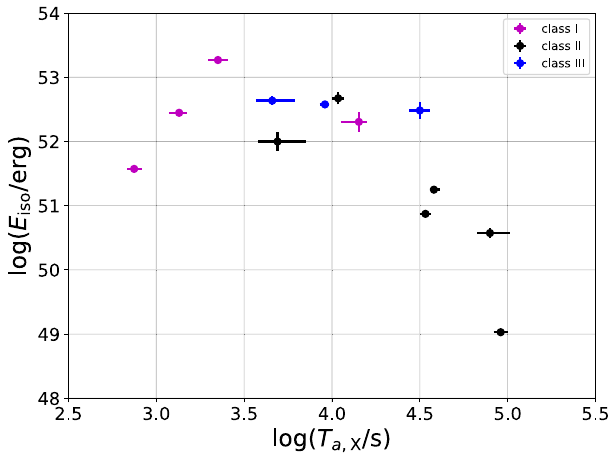
Fig. 1 | Total Isotropic Energy, E iso as a function of the time at the end of the plateau phase, T a,X in the X-ray band. Purple, black and blue points represent GRBs in the three different classes I, II, III respectively (see Supplementary Tables 1 – 3). The errors correspond to a signi fi cance of one sigma. Note that these threeclasses,selectedonlybasedonthetemporalindicesoftheirX-rayandoptical afterglow light curves, are correlated with the prompt phase energy as well as the break time: each class occupiesa different regionin the E iso - T a,X parameter space. This fact provides a further, independent tool that increases our con fi dence in the selection criteria we use for these classes. The source data to reproducethis fi gure are provided as a Source Data fi